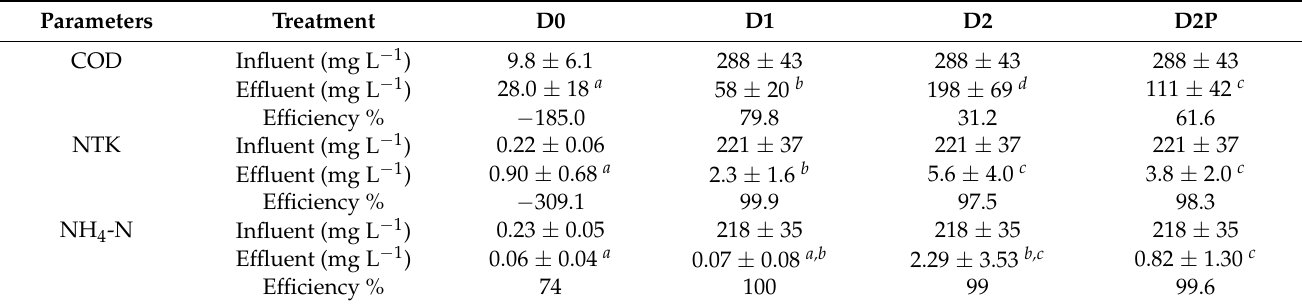
Table 2. Efficacy of COD and nitrogen removal by the willow filter. Efficacy was calculated as the